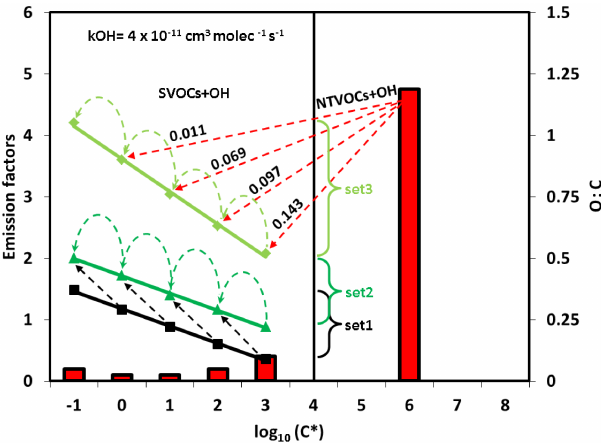
Figure 1. Proposed oxidation scheme: an average mixture of NTVOCs compounds are allowed to react with the hydroxyl rad- ical following a naphthalene kernel mass distribution. Secondary products in the SOA set (set 3) are allowed to further react with a reaction rate of k OH = 4 . 0 × 10 − 11 cm 3 molec − 1 s − 1 . Oxidation products from semi-volatile vapours from the POA set (set 1) are allowed for further aging in set 2. The numbers on the red arrows indicate the NTVOCs yields for each bin for the best-fitting solution (ppmppm − 1 )